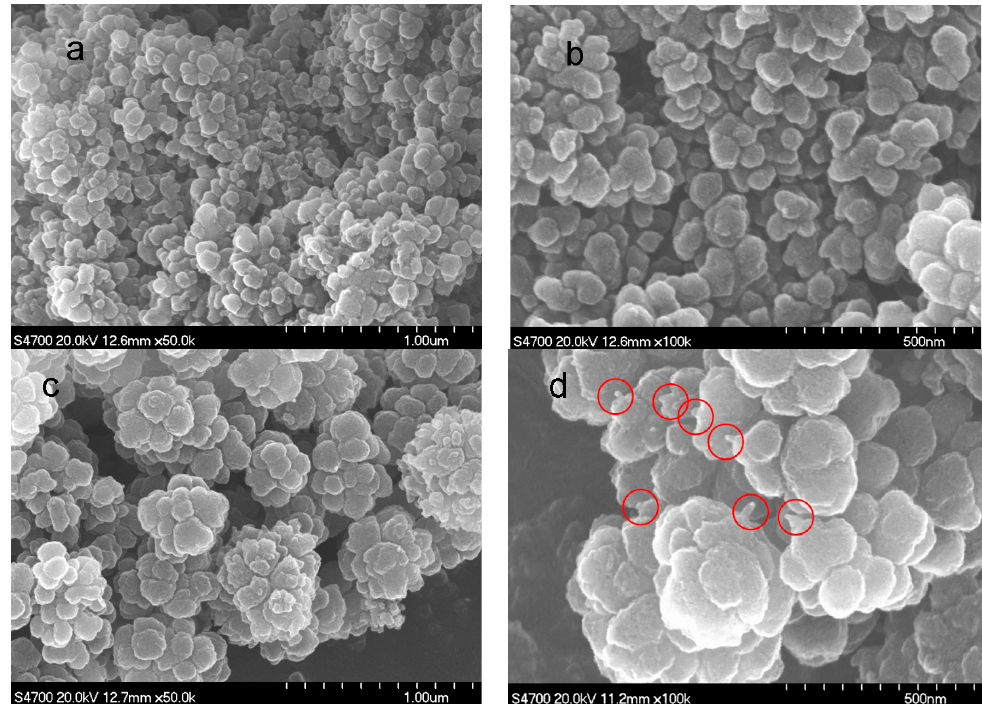
Figure 2. Scanning electron microscopy (SEM) images of ( a , b ) the PAN homopolymer and ( c , d ) the amino-CNT/PAN microspheres.